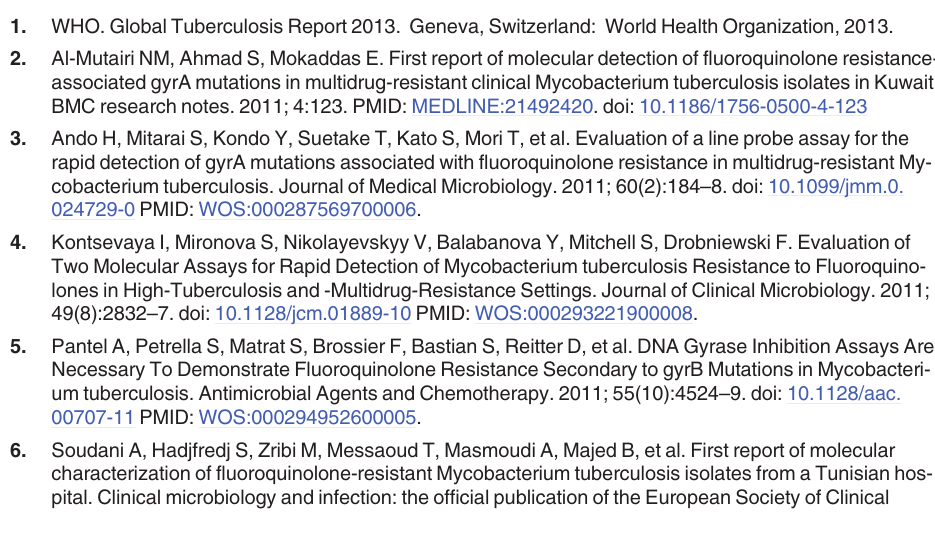
S1 Table. List of all mutations not meeting criterion for inclusion.